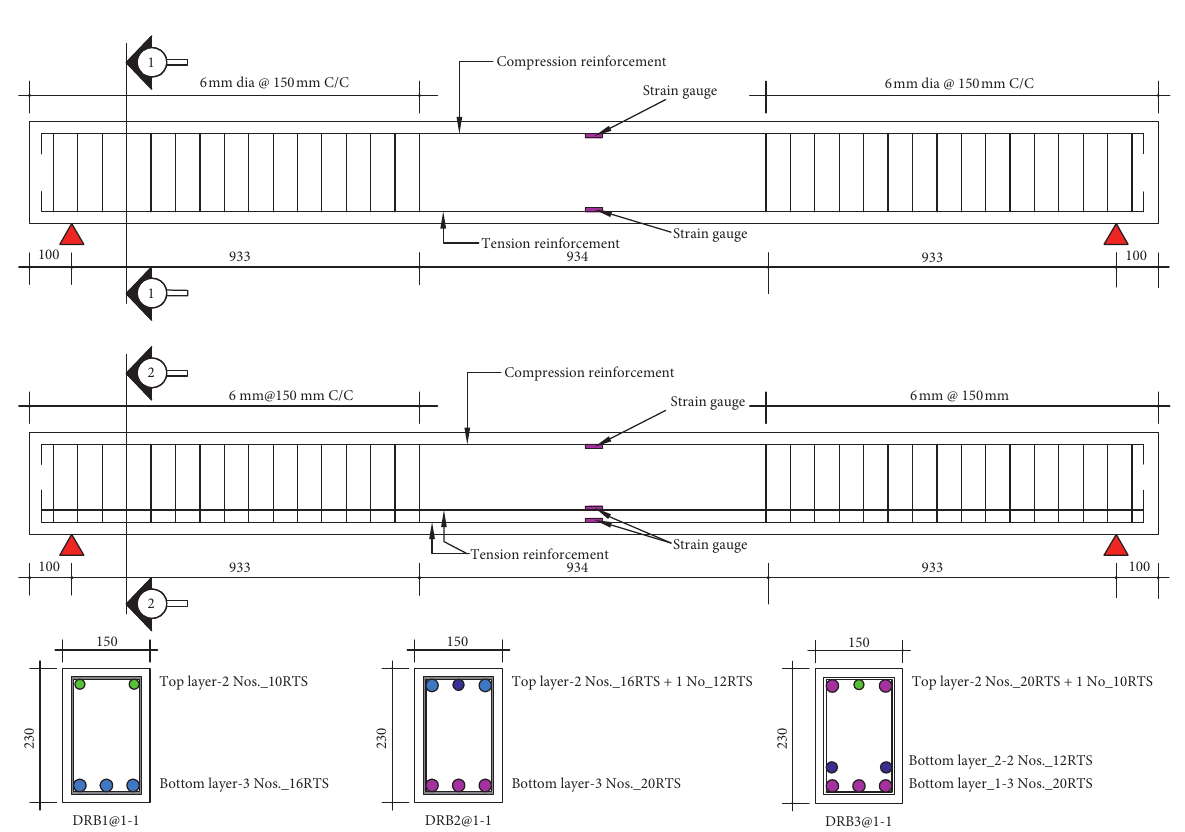
Figure 3: Reinforcement details and strain gauge location for DRB (D1, D2, and